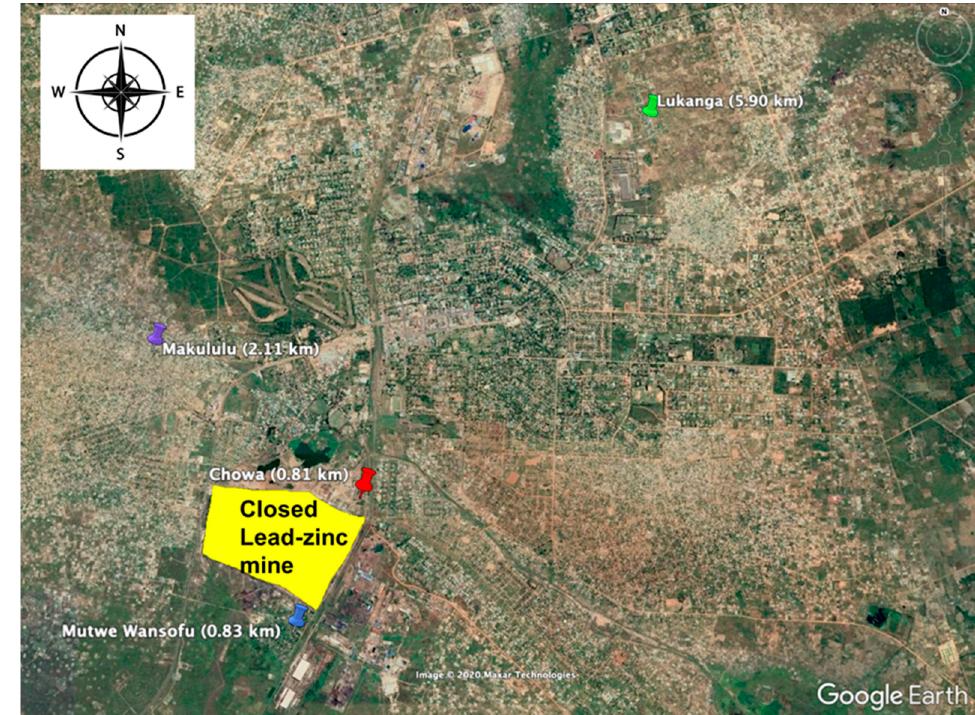
Figure 1. Sampling sites for wild rats. Mutwe Wansofu (MW; n = 6), Chowa (CH; n = 6), Makululu (MK; n = 6), and Lukanga (LK; n = 6). The closed Pb–Zn mine is shown with a “yellow” shape.